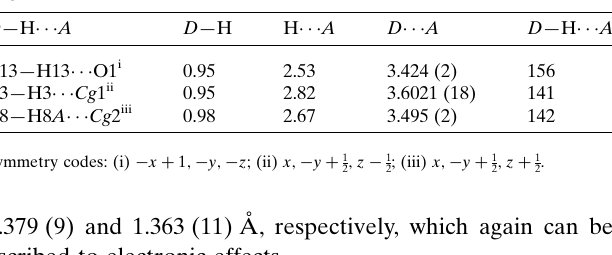
(Table 3) arising from benzene and adjacent methine C—H groups, which link the molecules into [010] chains (Fig. 6), with